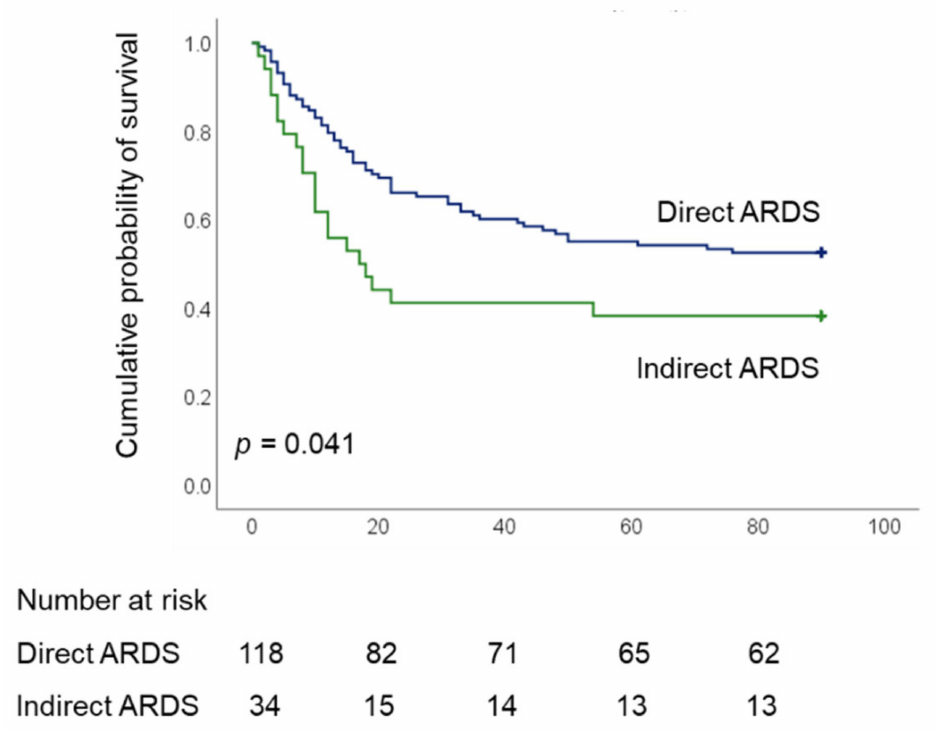
Figure 2. Kaplan–Meier 90-d survival curves of patients undergoing ECMO for severe acute respira- tory distress syndrome, as stratified by direct and indirect ARDS (ARDS, acute respiratory distress syndrome; ECMO, extracorporeal membrane